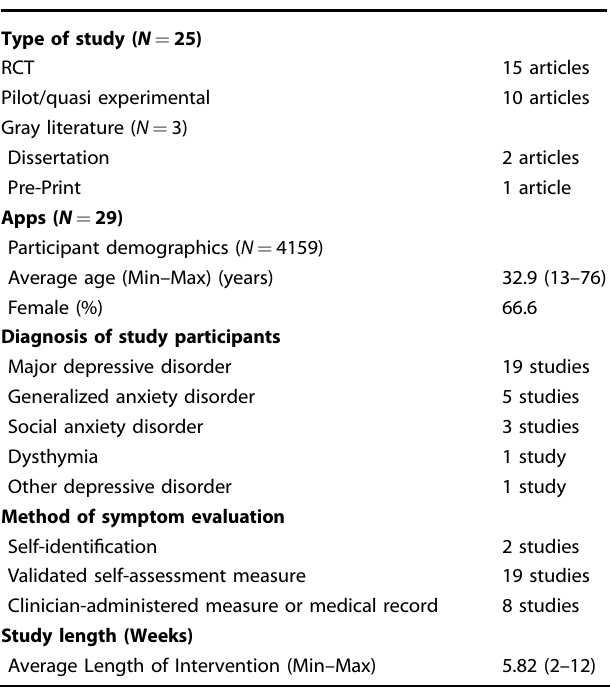
Table 1. Study characteristics. Table 2. Components of persuasive design.